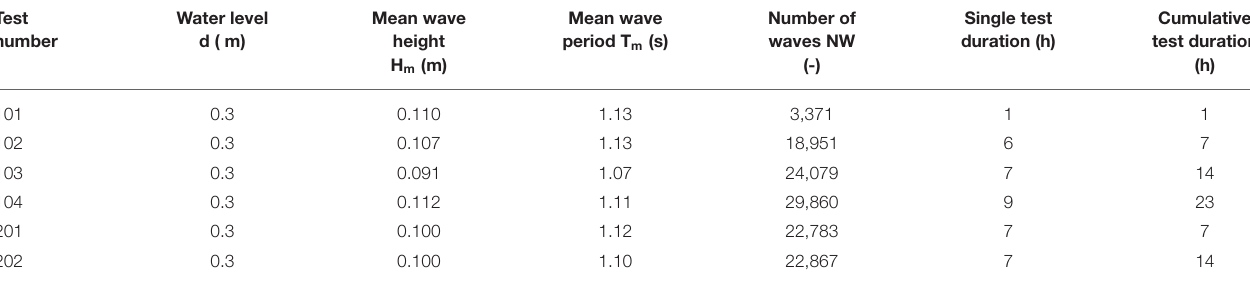
TABLE 1 | Hydraulic boundary conditions.